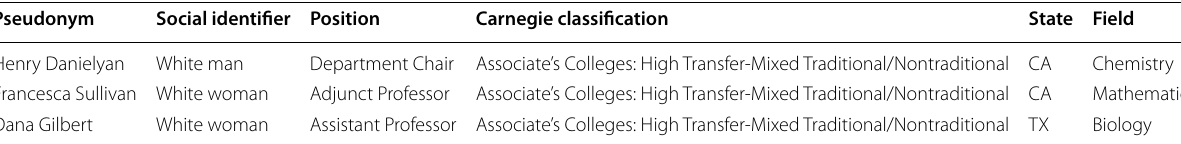
Table 6 Demographics, position, field, and institution type and location for three case